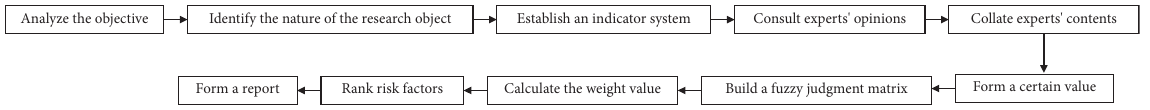
Figure 1: Specific operation process.